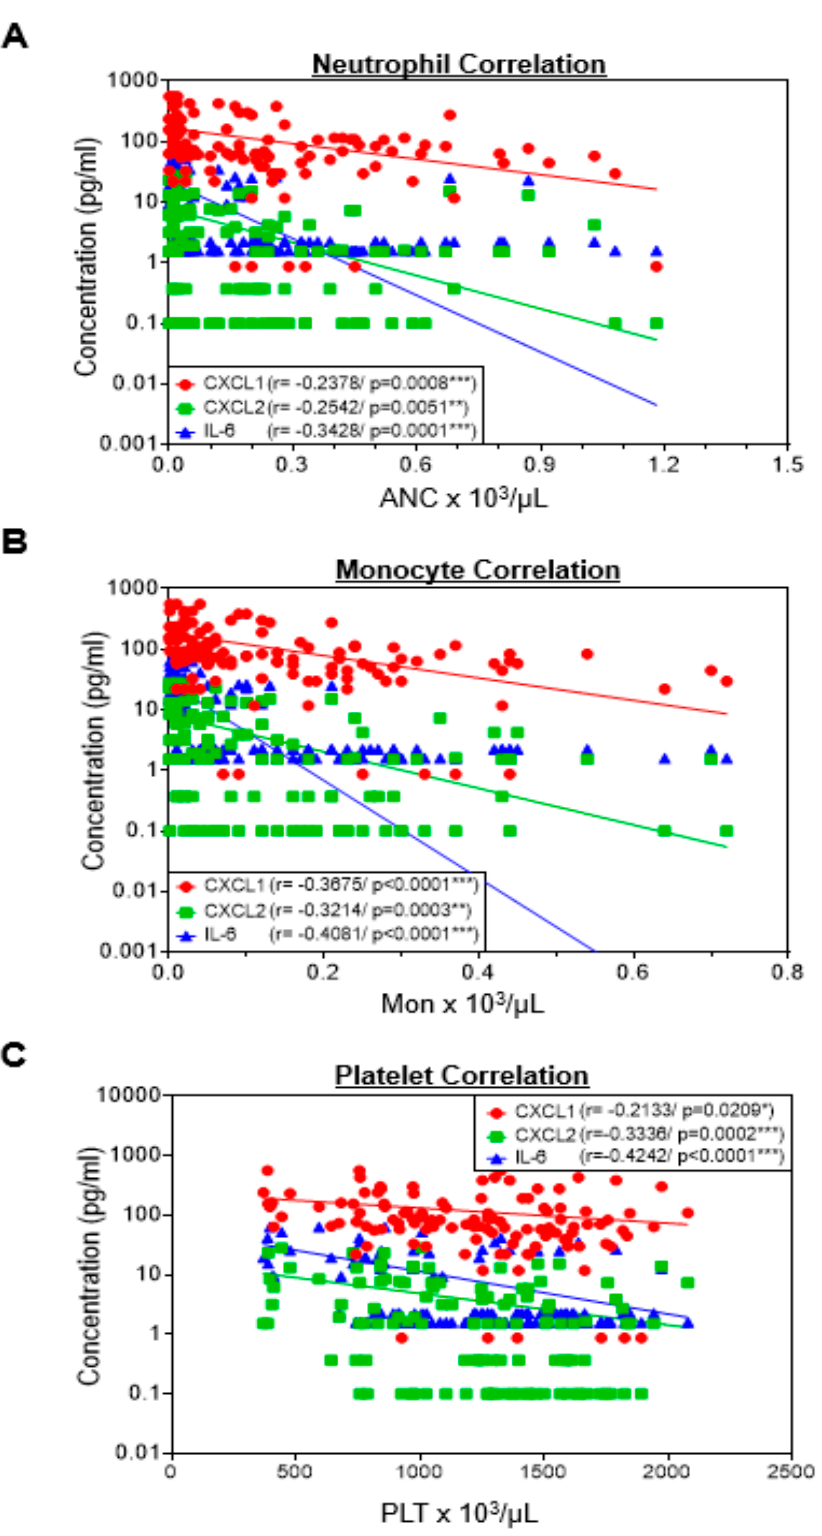
Figure 4. Correlation between hematology and pro-inflammatory cytokine / chemokines in 5-FU-treated mice. The blood samples were harvested from mice ( n = 40 males per day) on days 5, 6, and 7 after 5-FU (100 mg / kg) treatment. Correlation plot between ( A ) ANCs, ( B ) monocytes, or ( C ) platelets and pro-inflammatory cytokine / chemokines the chemokine (C–X–C motif) ligand 1 (CXCL1), CXCL2, and interleukin (IL)-6 (Pearson’s correlations).